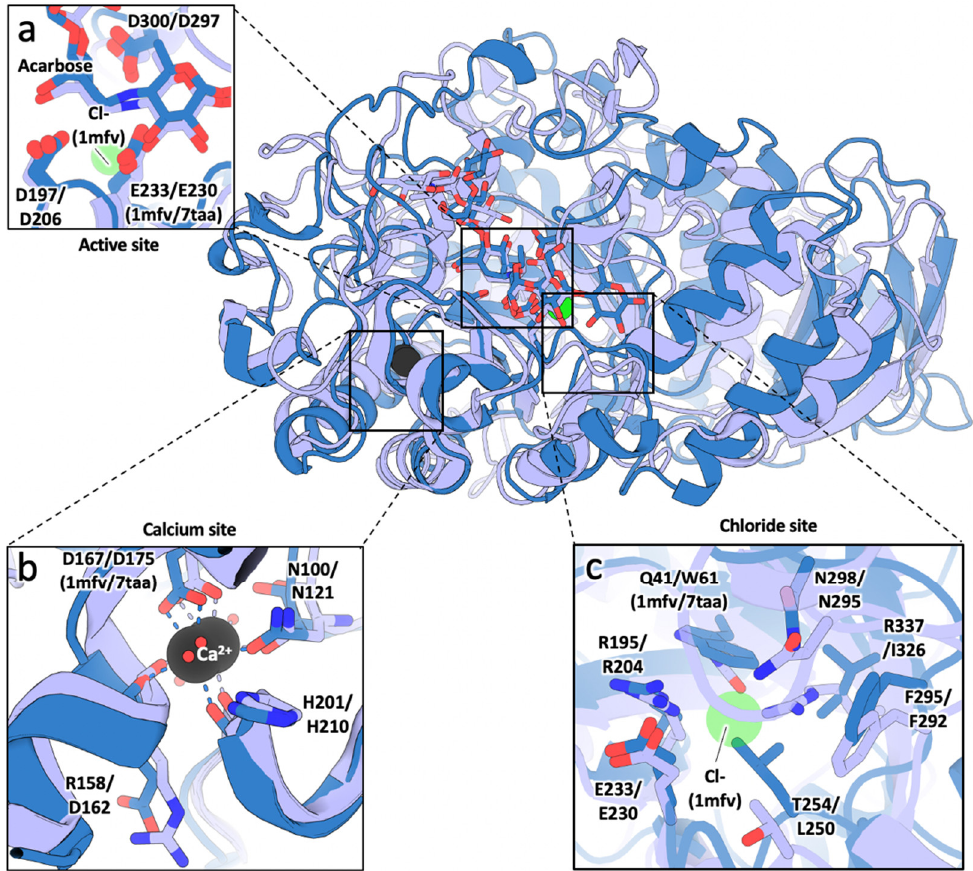
Figure 3. Structural superposition of HSA (lilac) and AOA (blue). Ions are represented as spheres, the catalytic triad and the substrate as sticks and the protein as cartoon (PDB ID: 1mfv and 7taa for HSA ad AOA, respectively). Coordinating water molecules are shown as red spheres. ( a ) Superposition of the catalytic triad ( b ) Superposition of the calcium-binding site. ( c ) Superposition of the chloride-binding site. Coordinating water molecules have been omitted for clarity.